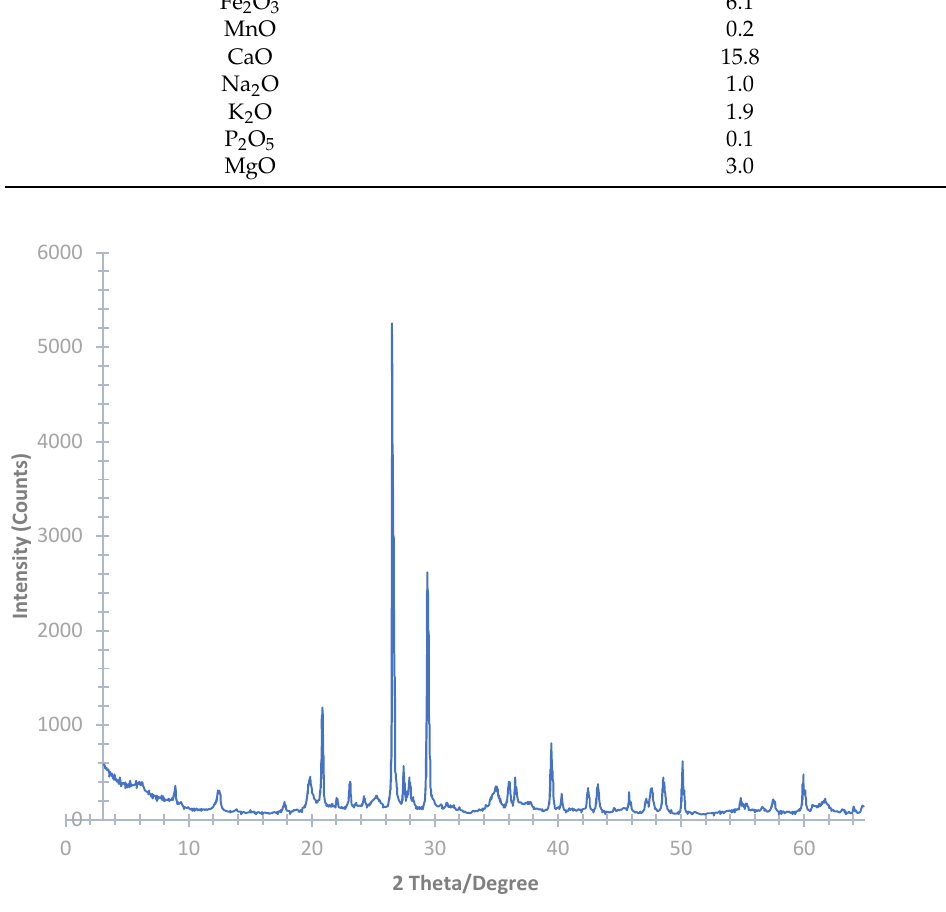
Figure 3. XRD of the uncalcined silt.